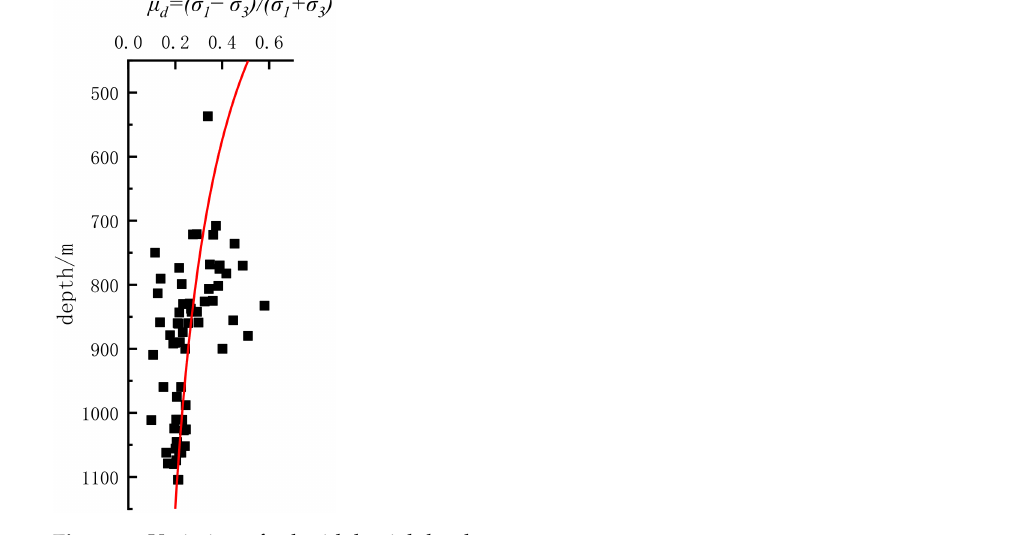
Figure 6. Variation of µ d with burial depth.